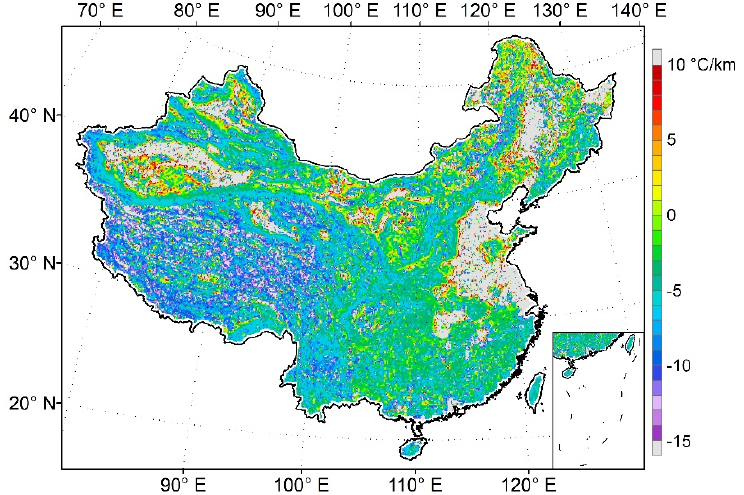
Figure 3. Spatial distribution of the annual average TLR during 2001–2015. The spatial resolution is 10 km × 10 km. The color bar shows twenty-seven levels of the TLR. A big difference was found in the seasonal distribution (Figures 4 and 5). The